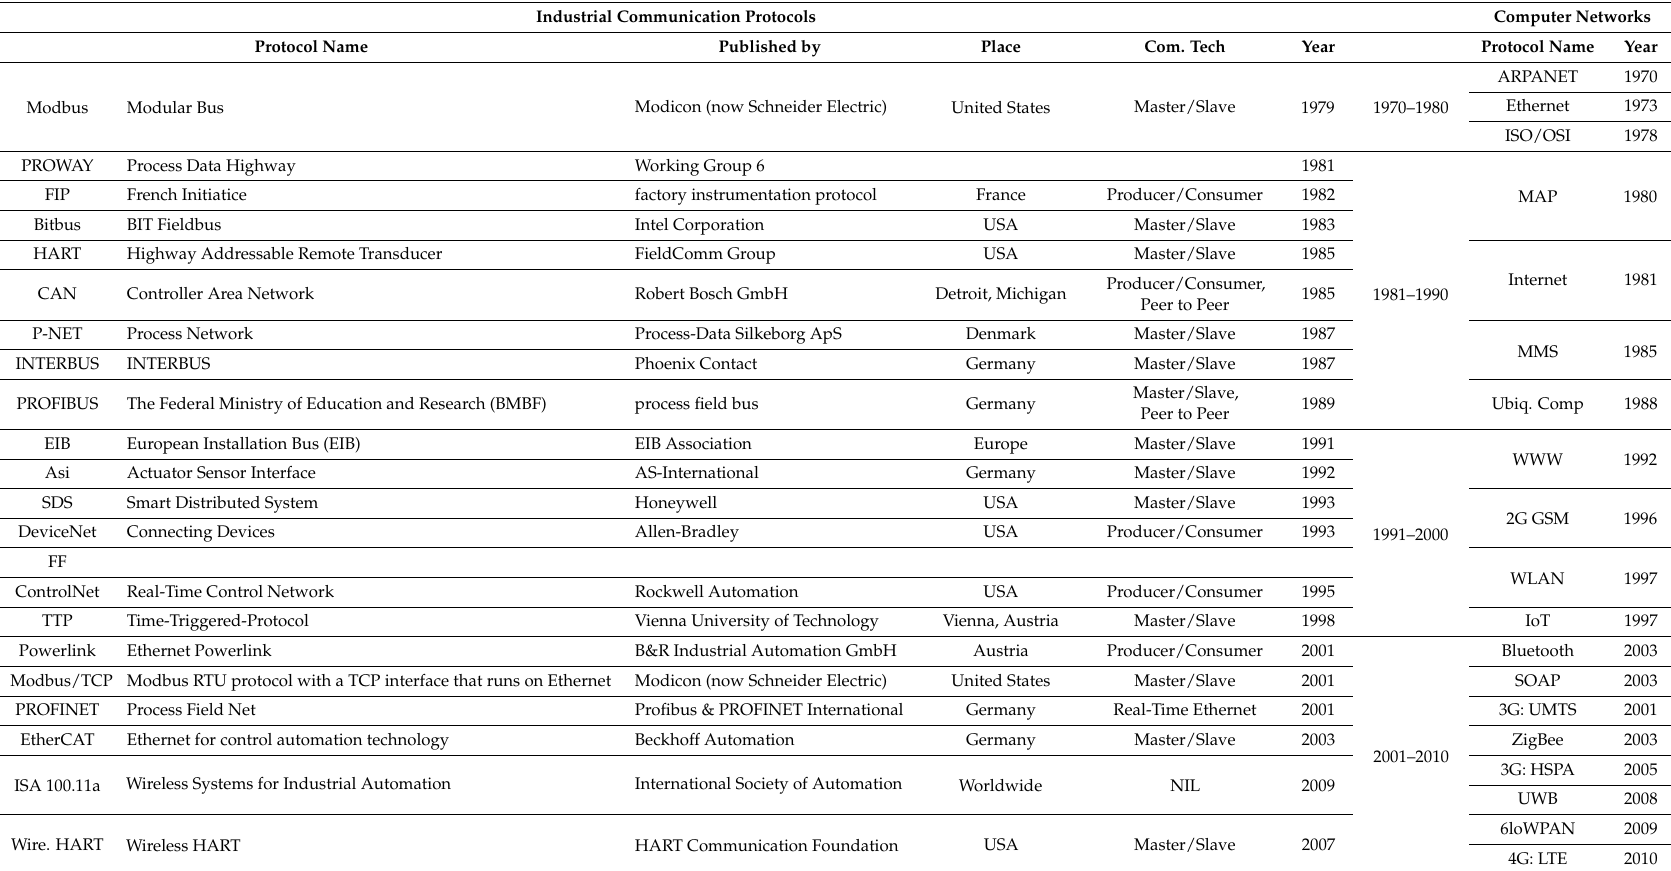
Table 1. Industrial communication protocols